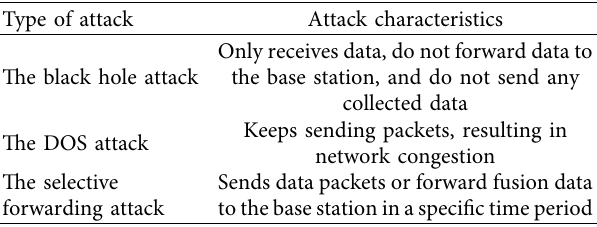
Table 3: Recognition rate analysis.